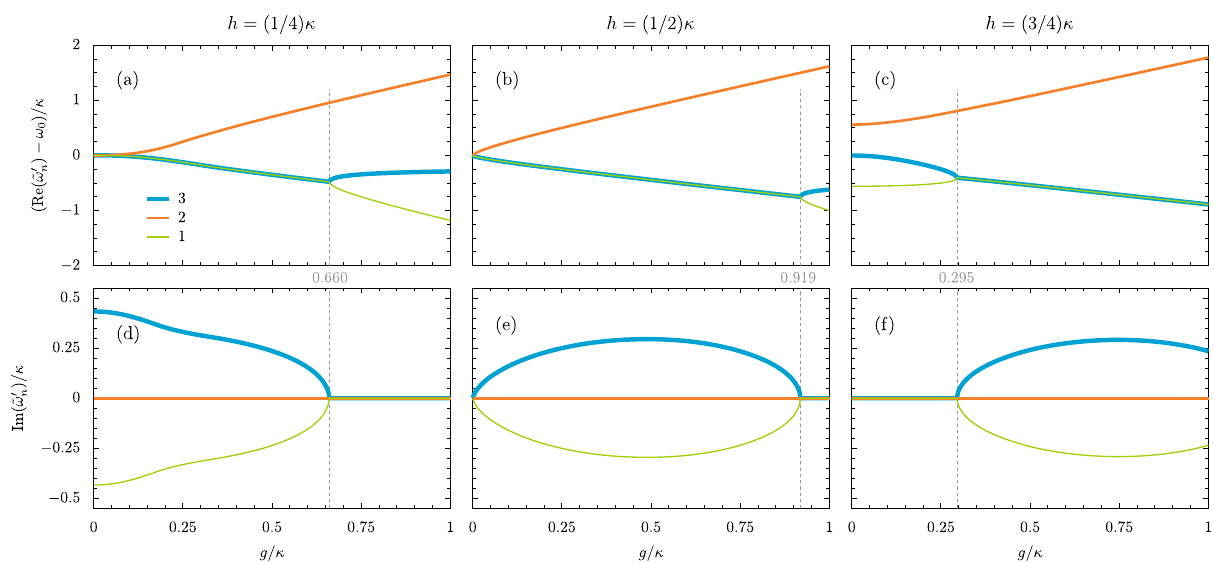
, as a function of the n are denoted by the thin green, n